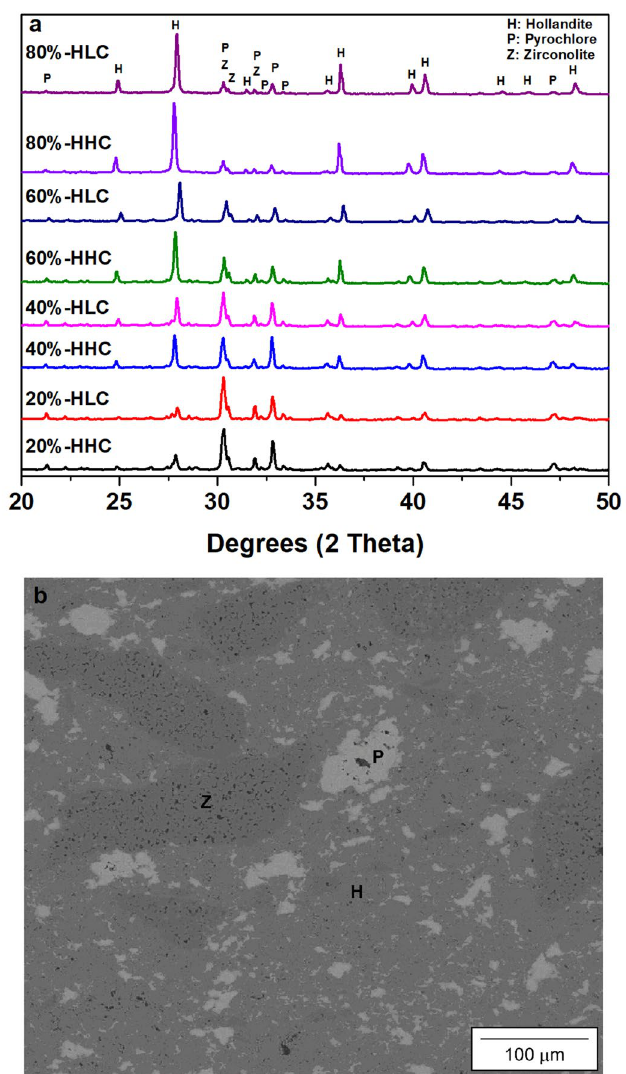
Figure 6. XRD patterns of designer waste forms fabricated using both high (HHC) and low (HLC) Cs content hollandite compositions ( a ) and the microstructure of 60%-HLC ( b